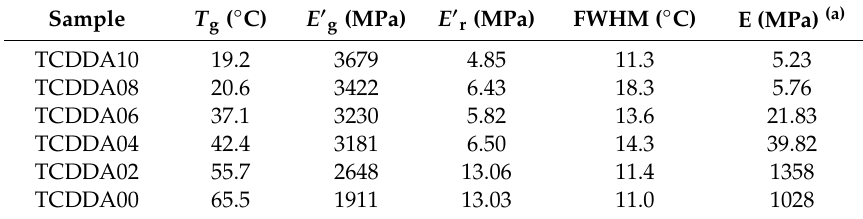
Table 2. Thermomechanical data collected from DMA (dynamic mechanical analysis). Coe ffi cients of variation less than 2% for thermomechanical data and 5% for Flexural Modulus.